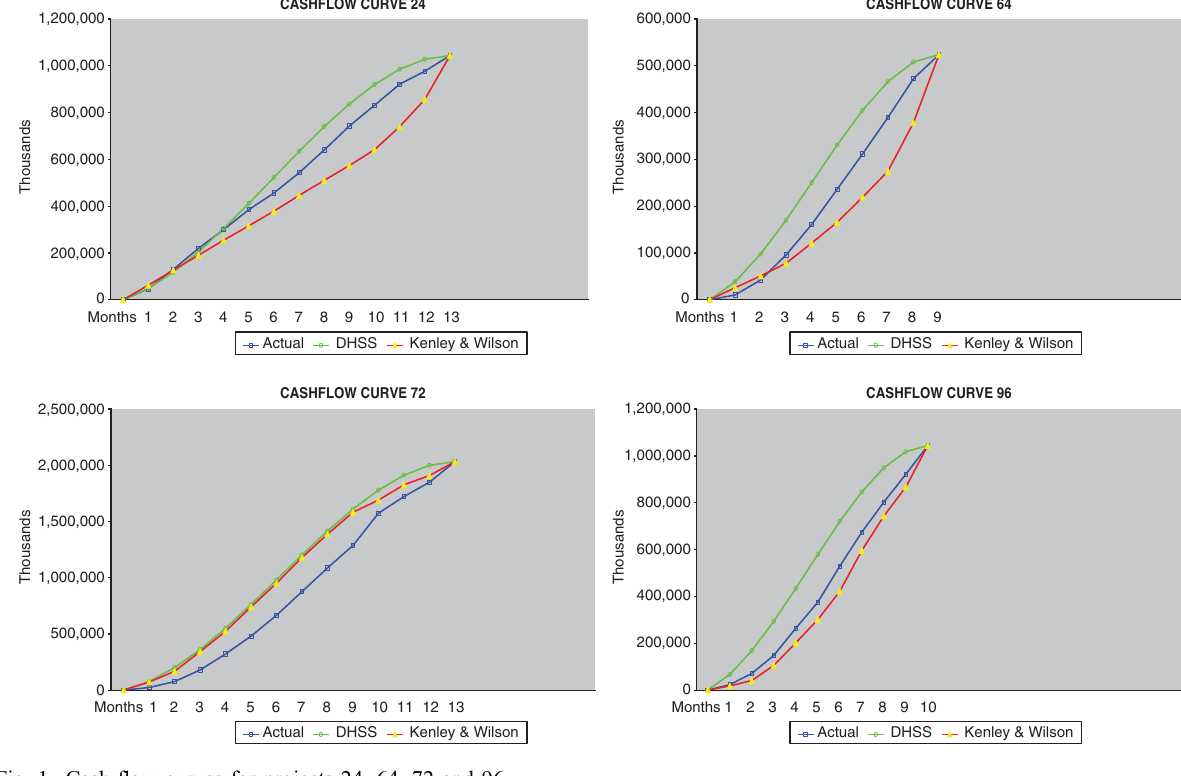
Fig. 1. Cash fl ow curves for projects 24, 64, 72 and